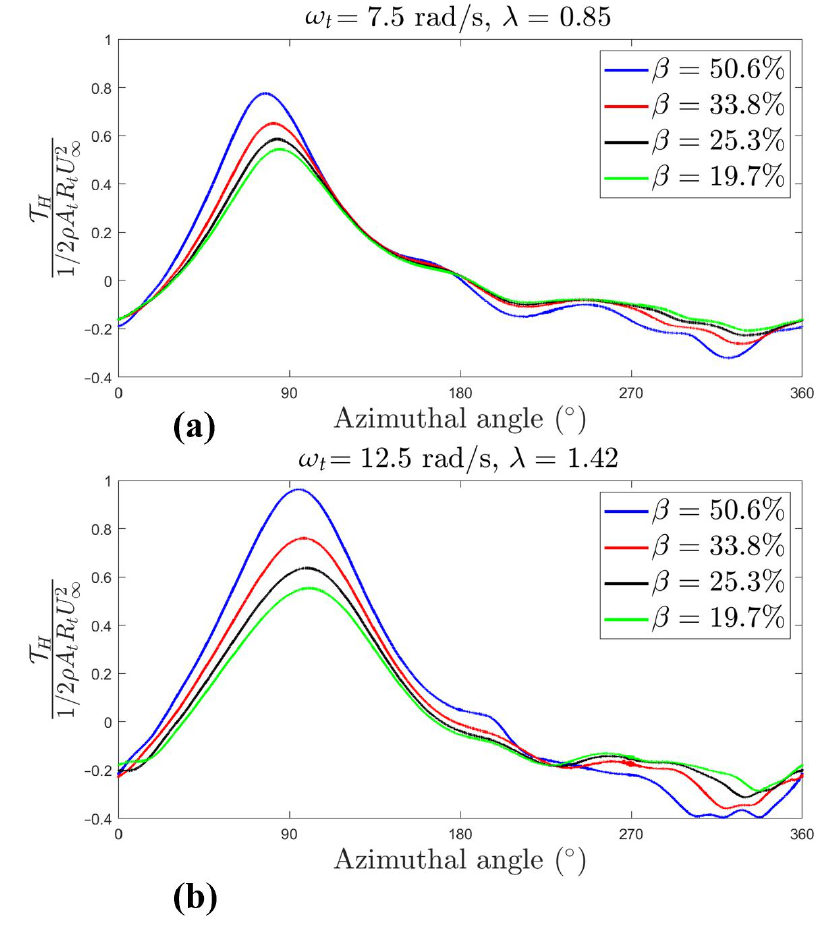
Figure 7. The torque as a function of the turbine azimuthal angle at 4 blockage ratios and 2 tip-speed- ratios λ = 0.85 ( a ) and λ = 1.42 ( b